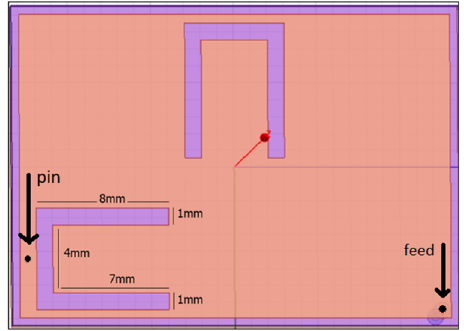
Figure 2. Proposed Antenna Characteristics.